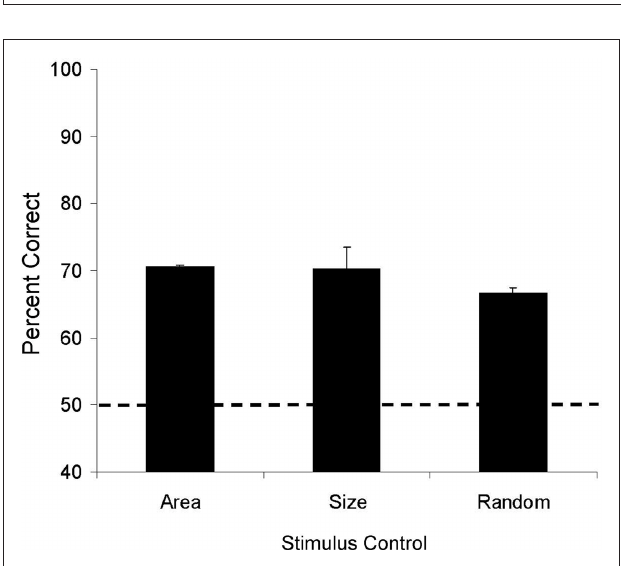
Figure 3 | Average accuracy during experiment 1 transfer for each of the three stimulus control classes. Error bars reflect the standard error of the mean and the dotted line indicates chance for the